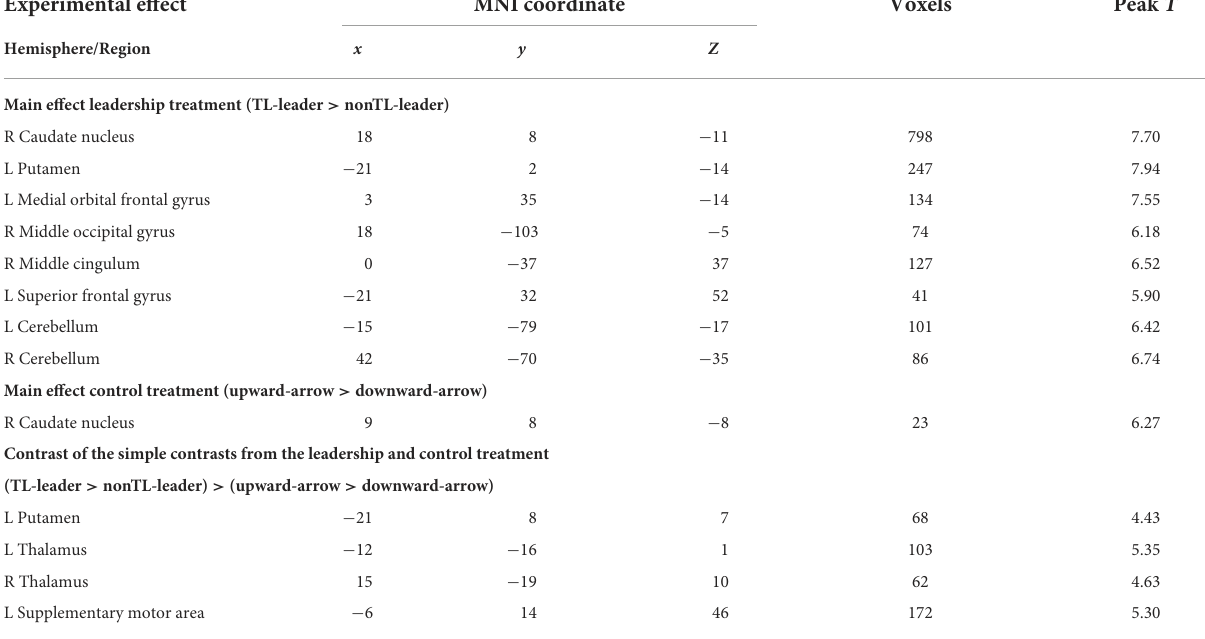
TABLE 1 T -values for significantly activated voxels, MNI coordinates, and cluster sizes. Experimental